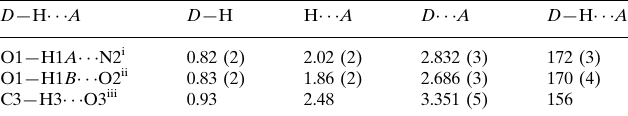
Hydrogen-bond geometry (A˚ , (cid:2)